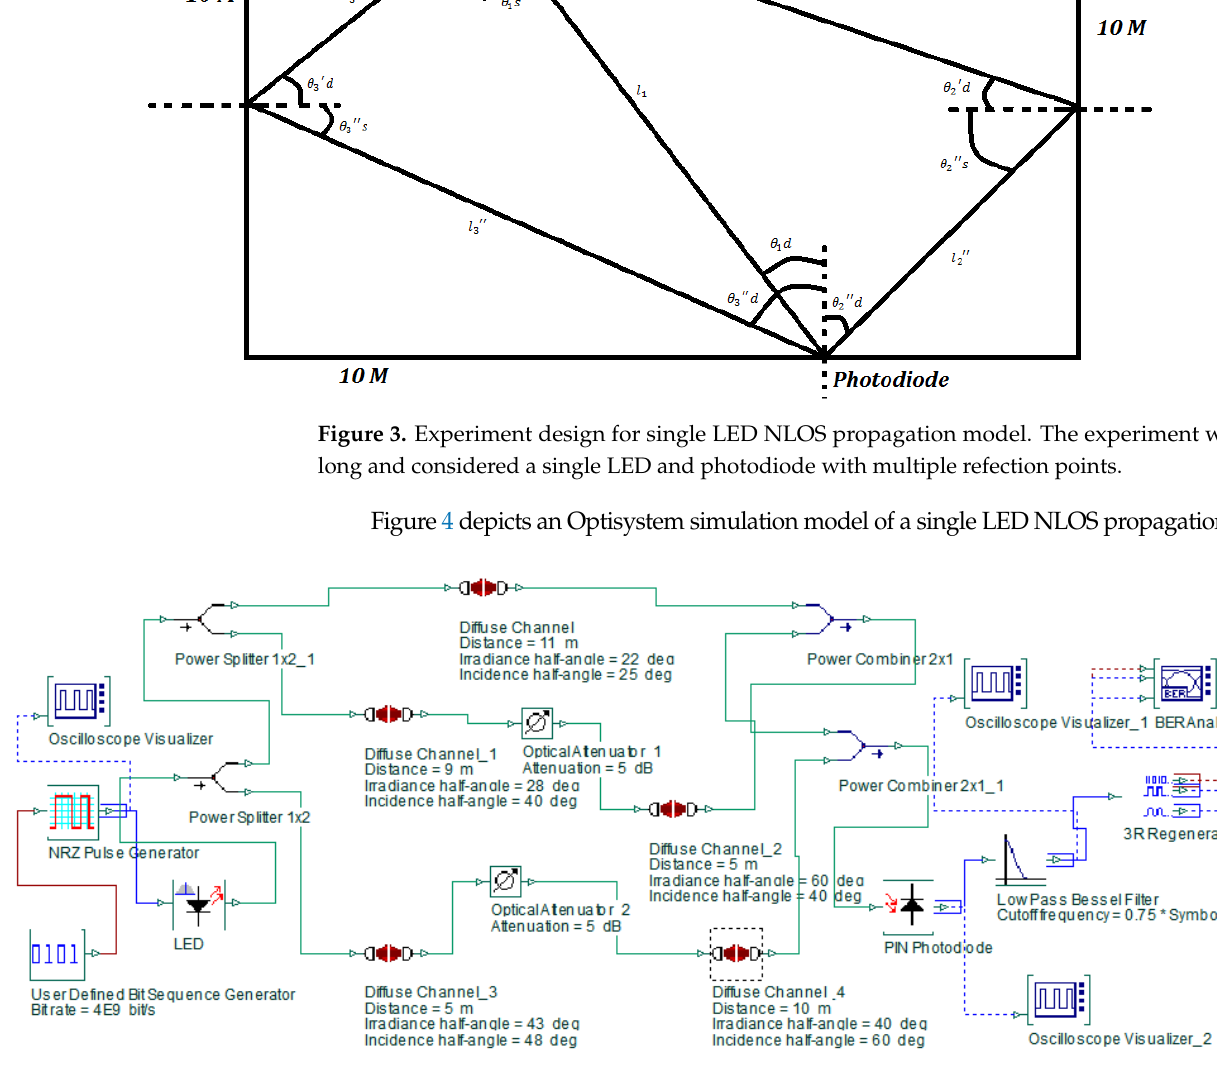
Figure 4. Single LED NLOS propagation model simulation environment in